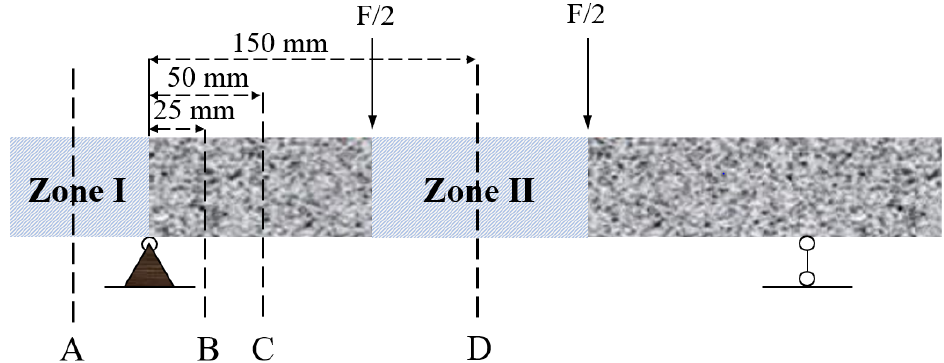
Figure 2. Schematic view of the carbonation depth measurement.